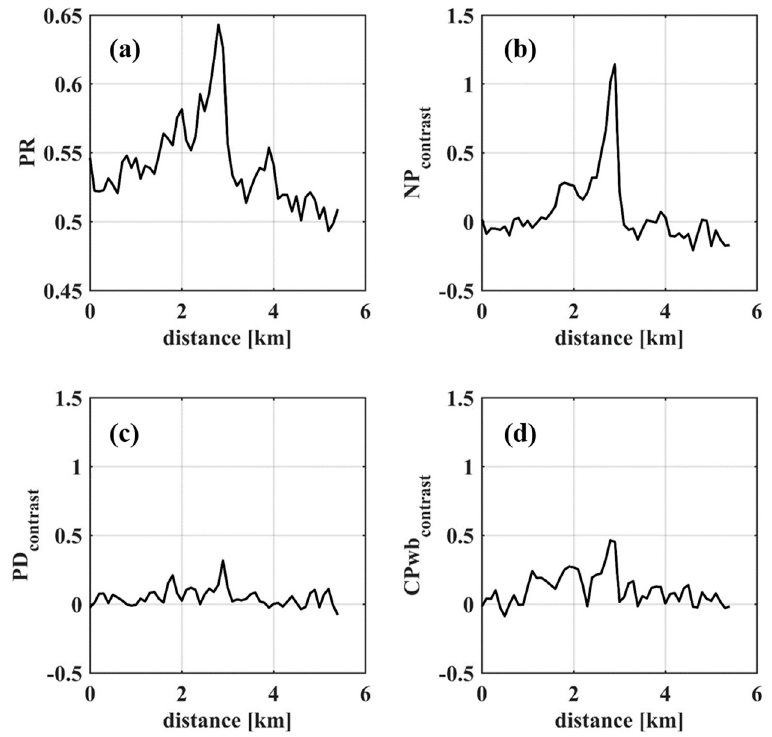
Figure 8. Transects across the current along the red arrow shown in Figure 7: ( a ) PR, ( b ) NP contrast, ( c ) PD contrast, ( d ) CPwb contrast.